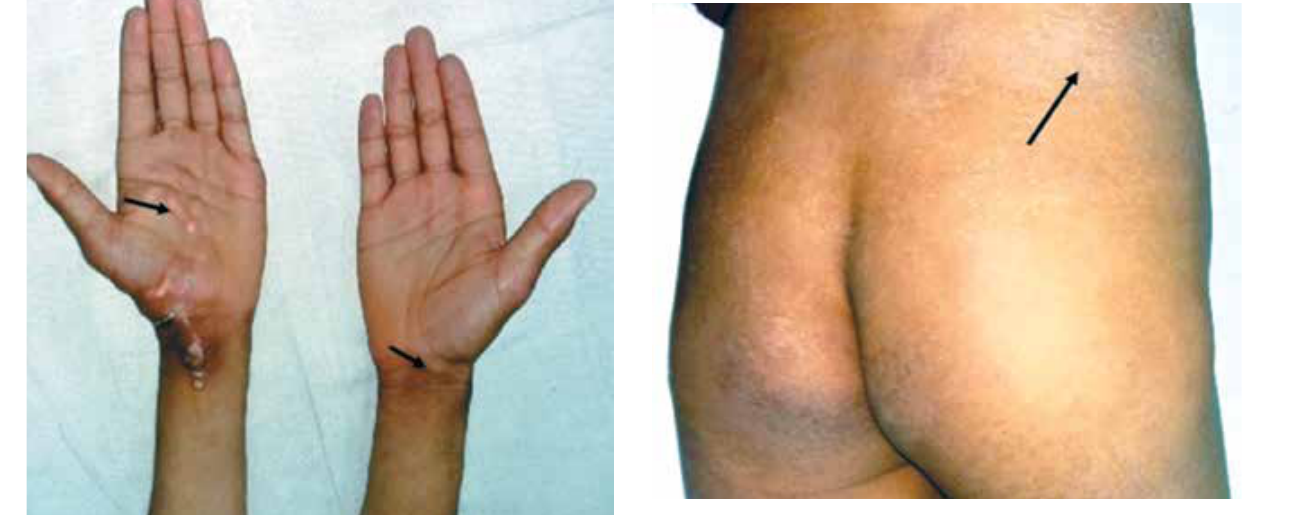
Fig 4. Symmetrical distribution of violaceous plaque with insterspersed hypopigmented macules and patches on